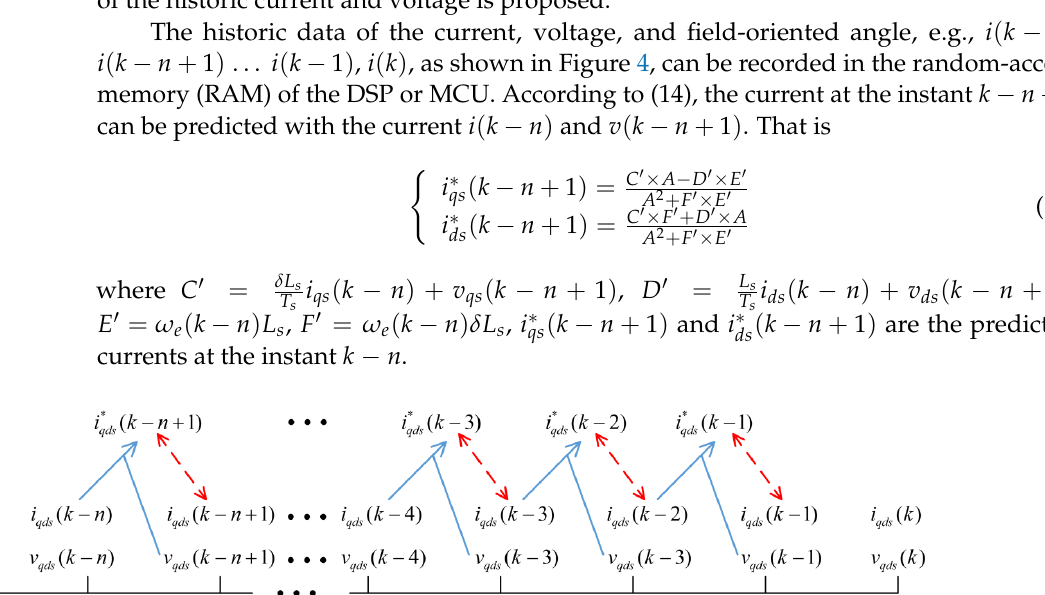
Figure 3. PI regulator used to tune the